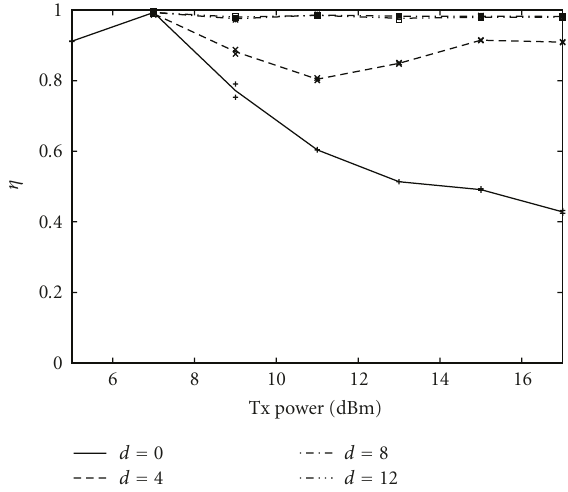
Figure 15: Far links, 802.11a: impact of channel separation and transmitted power on channel e ffi